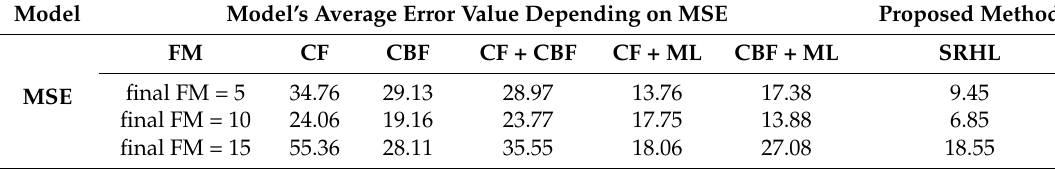
Table 10. Summary of average error value by MSE.